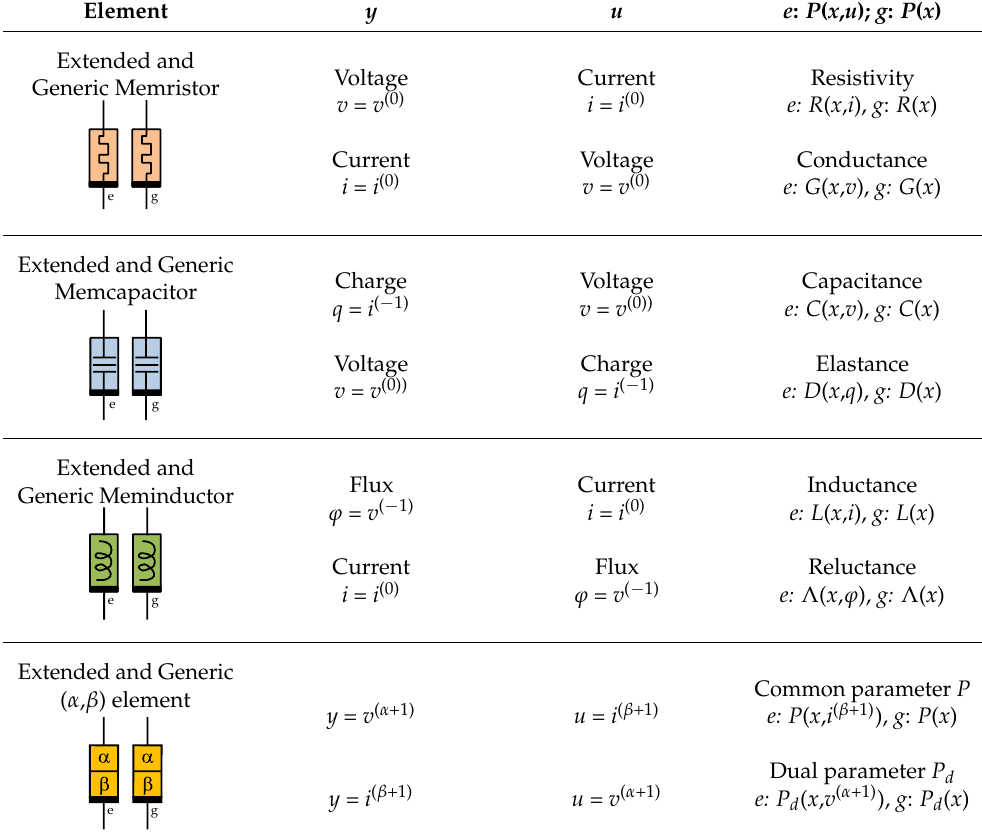
Table 1. Uniform description of extended (e) and generic (g) elements according to definition (2).